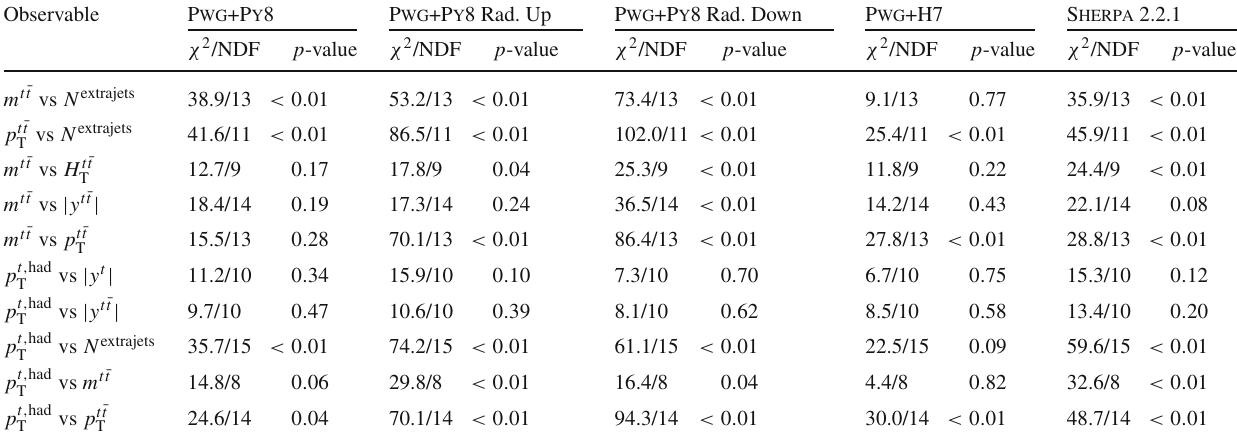
Table 16 Comparison of the measured particle-level absolute double- differential cross-sections in the boosted topology with the predictions from several MC generators. For each prediction a χ 2 and a p -value are